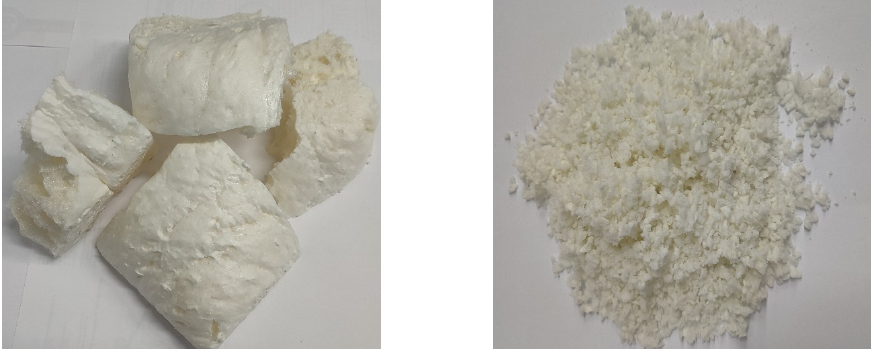
Figure 1. The appearance of PU foam ( left ) before and ( right ) after